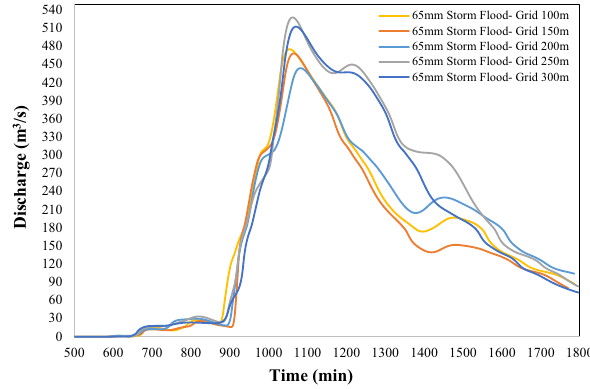
Fig. 20 Flood properties of calibrated GSSHA base model for a 24-h, 65 mm storm flood compared to hydrographs corresponding to GSSHA models with cell sizes of 100–300 m